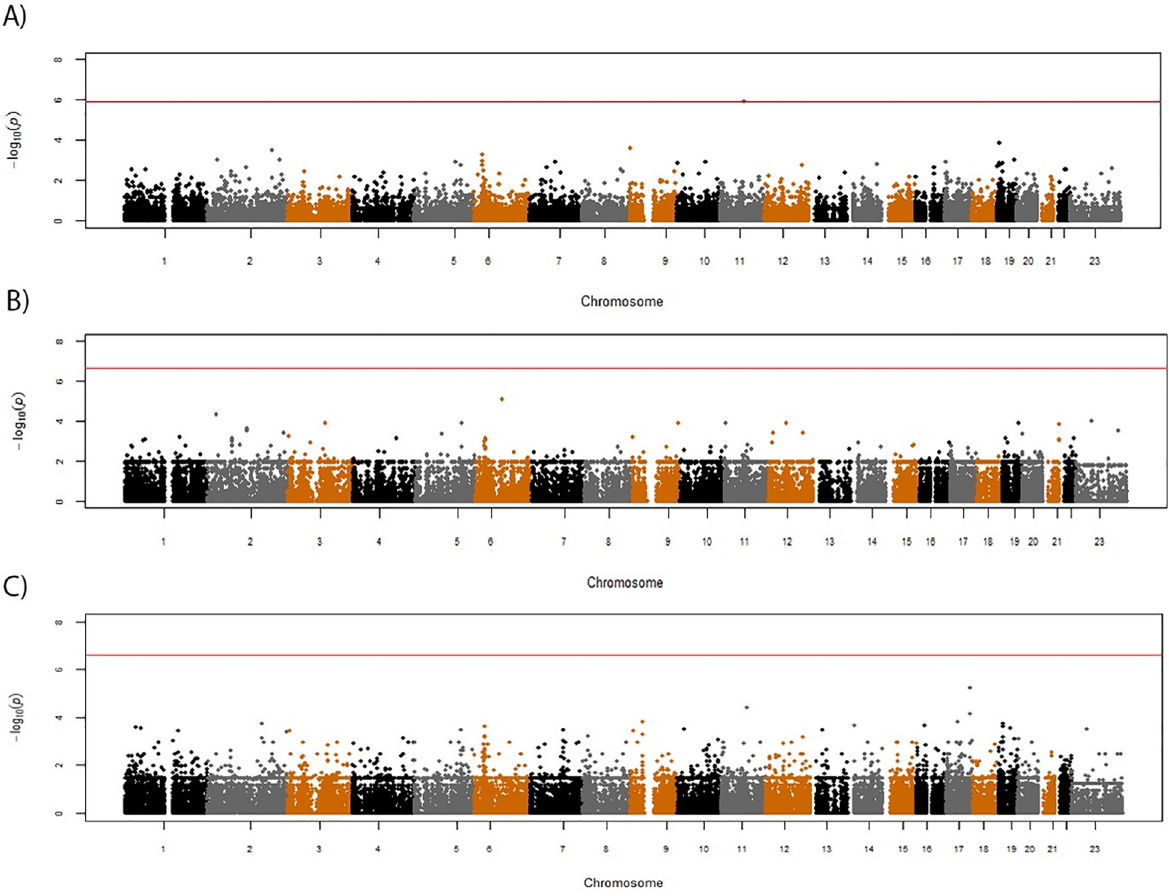
Fig 5. Manhattan plots of significance scores from single-variant analysis of exome sequencing data of patients selected from extremes of the CZP response distribution. In panel A, 19 CZP super-responders are compared to 55 non-responders. Panel B shows FET significance scores for 19 CZP super-responders compared to sequence data from a larger group of 1546 ethnically matched population controls and 55 non-responders, while panel C shows results of analysis of 55 CZP non-responders versus 1546 ethnically matched population controls and 19 super-responders. Horizontal red lines in figures A-C indicate the Bonferroni-corrected threshold for statistical